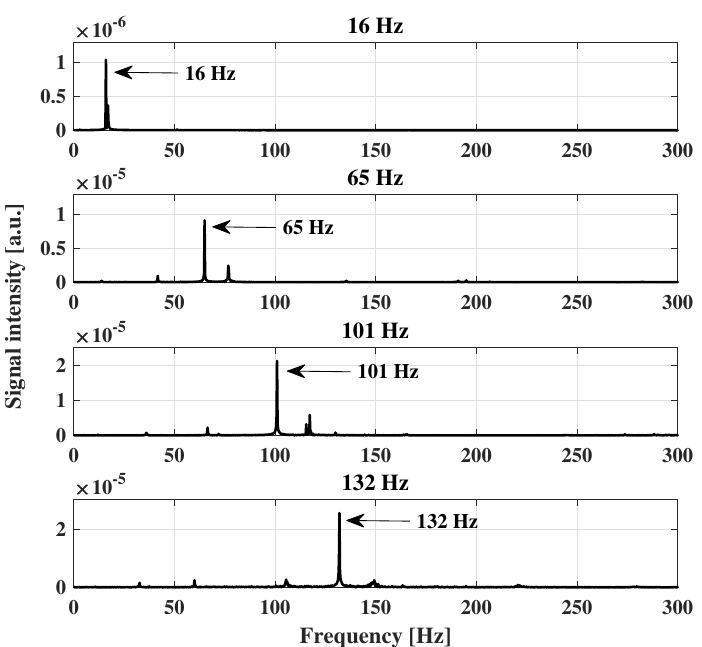
Figure 8. Harmonic response for each motor rotation velocity used in the dynamic FEM simulation.